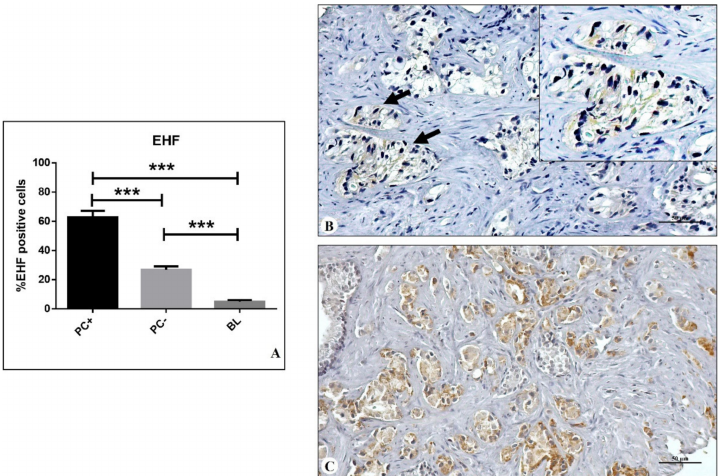
Figure 1. Immunohistochemical evaluation of EHF. ( A ) Graph shows the percentage of EHF-positive cells in prostate lesions that developed metastasis within 5 years of the first diagnosis (PC+), prostate lesions that did not develope metastasis within 5 years from the first diagnosis (PC − ), and benign lesions (BL). ( B ) PC − lesion with EHF-positive cells ≤ 30% (arrows). ( C ) PC+ lesion with EHF-positive cells ≥ 30%. *** p <